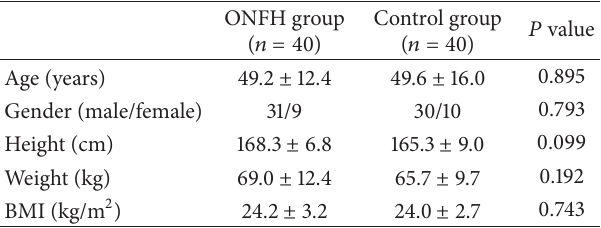
Table 2: Demographic data of ONFH group and control group.